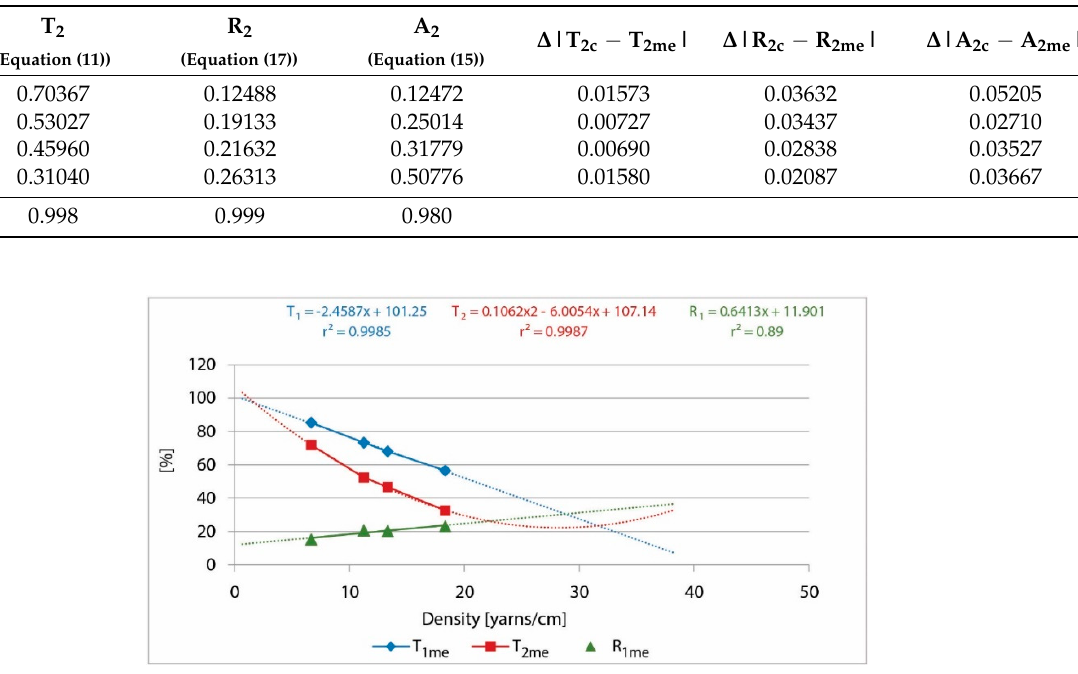
Table 10. Calculated values ( c ) of UV parameters double- (T 2 , R 2 , A 2 ) layered PET samples and the absolute values of their differences compared with measurement ( me ) values and the conformation of their connections with the coefficient of correlation.